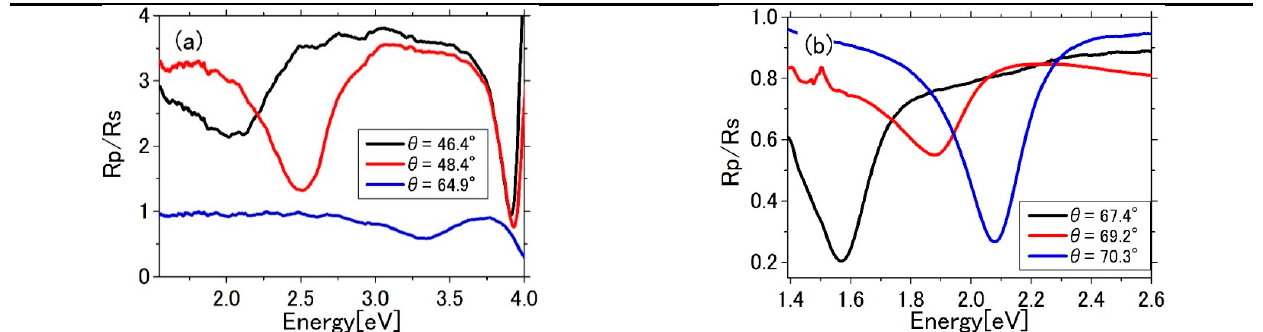
Figure 2. Reflection spectra of Ag in contact with ( a ) air and ( b ) water. The incidence angle θ in the prism was calculated as θ = 45 ◦ + sin − 1 [ sin ( θ a − 45 ◦ ) /1.47 ] from the incidence angle θ a in air [12] with the quartz refractive index 1.47. (For example, θ = 70.3 ◦ when θ a = 84 ◦